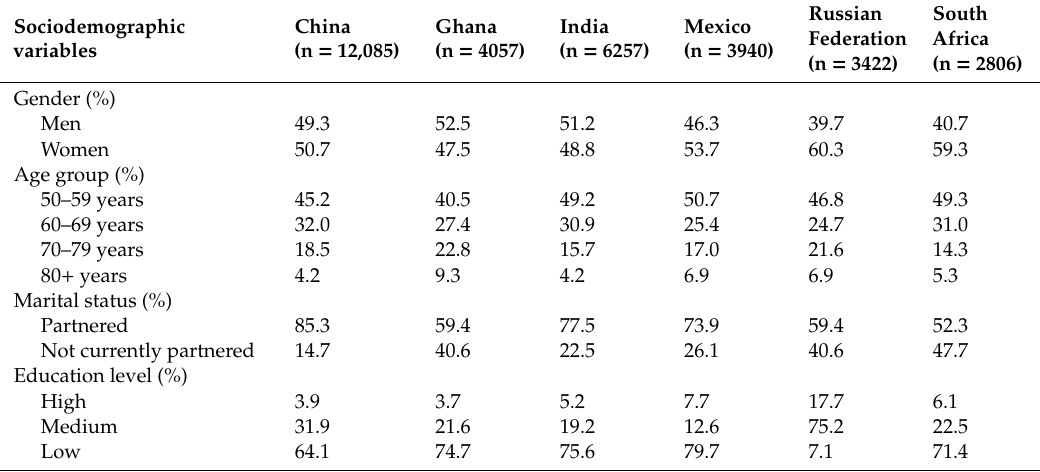
Table 1. Sociodemographic characteristics of respondents and distribution of body mass index, physical activity level, and self-reported chronic disease among respondents aged 50 + , by country, WHO Study on Global AGEing and Adult Health (WHO SAGE) Wave